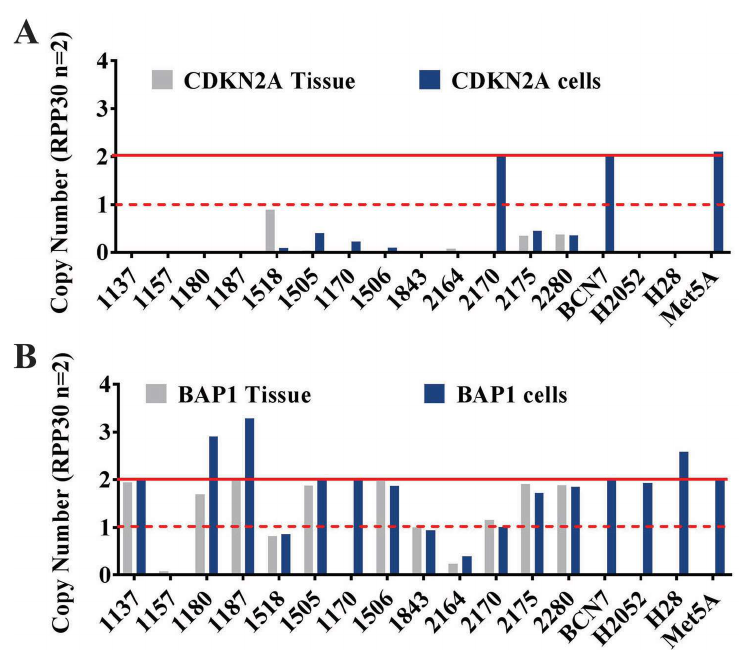
Figure 3. CDKN2A and BAP1 protein loss is due to copy number. Copy number (Blue = results from cell line, grey = results from tumor tissue, red line = two copies, red dotter line = one copy) of ( A ) CDKN2A and ( B ) BAP1 in MPM tumor and its derivative cells normalized to the ribonuclease P protein subunit p30 ( RPP30 ) assessed by droplet digital PCR (ddPCR).